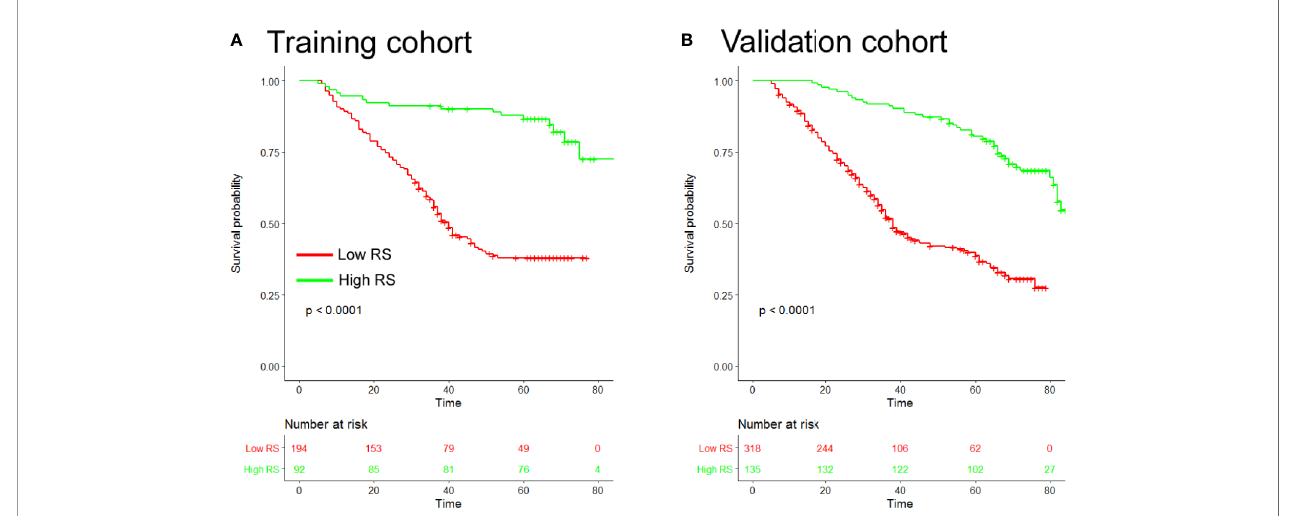
FIGURE 1 | Kaplan-Meier analyses of disease-free survival (DFS) according to the radiomic signature in patients with gastric cancer (A) . Training cohort (n=286) (B) , Validation cohort (n=453). RS, radiomic signature.